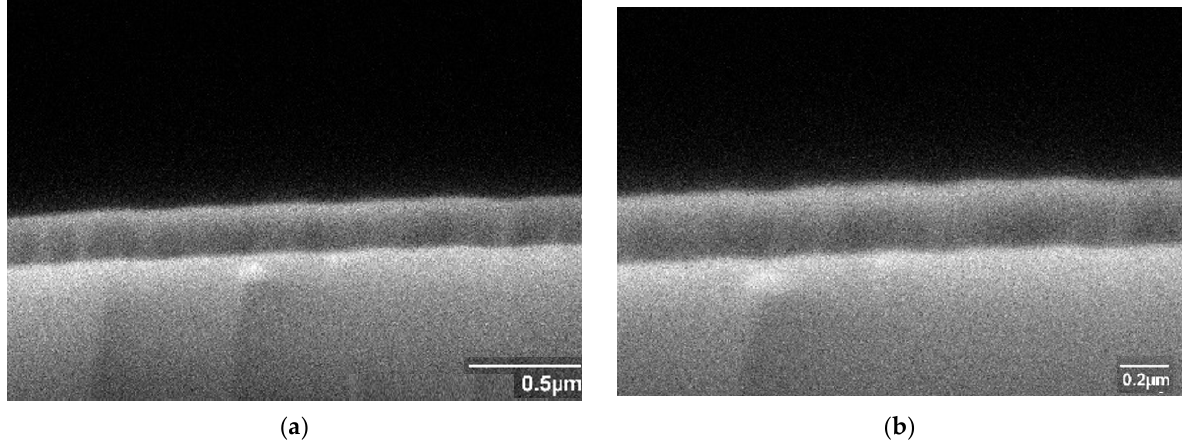
Figure 10. Micrographs were obtained via transmission electron microscopy. ( a ) Bi 3 . 75 La 0 . 25 Ti 3 O 12 film and ( b ) Bi 3 La 1 Ti 3 O 12 film. film and ( b ) Bi 3 La 1 Ti 3 O 12